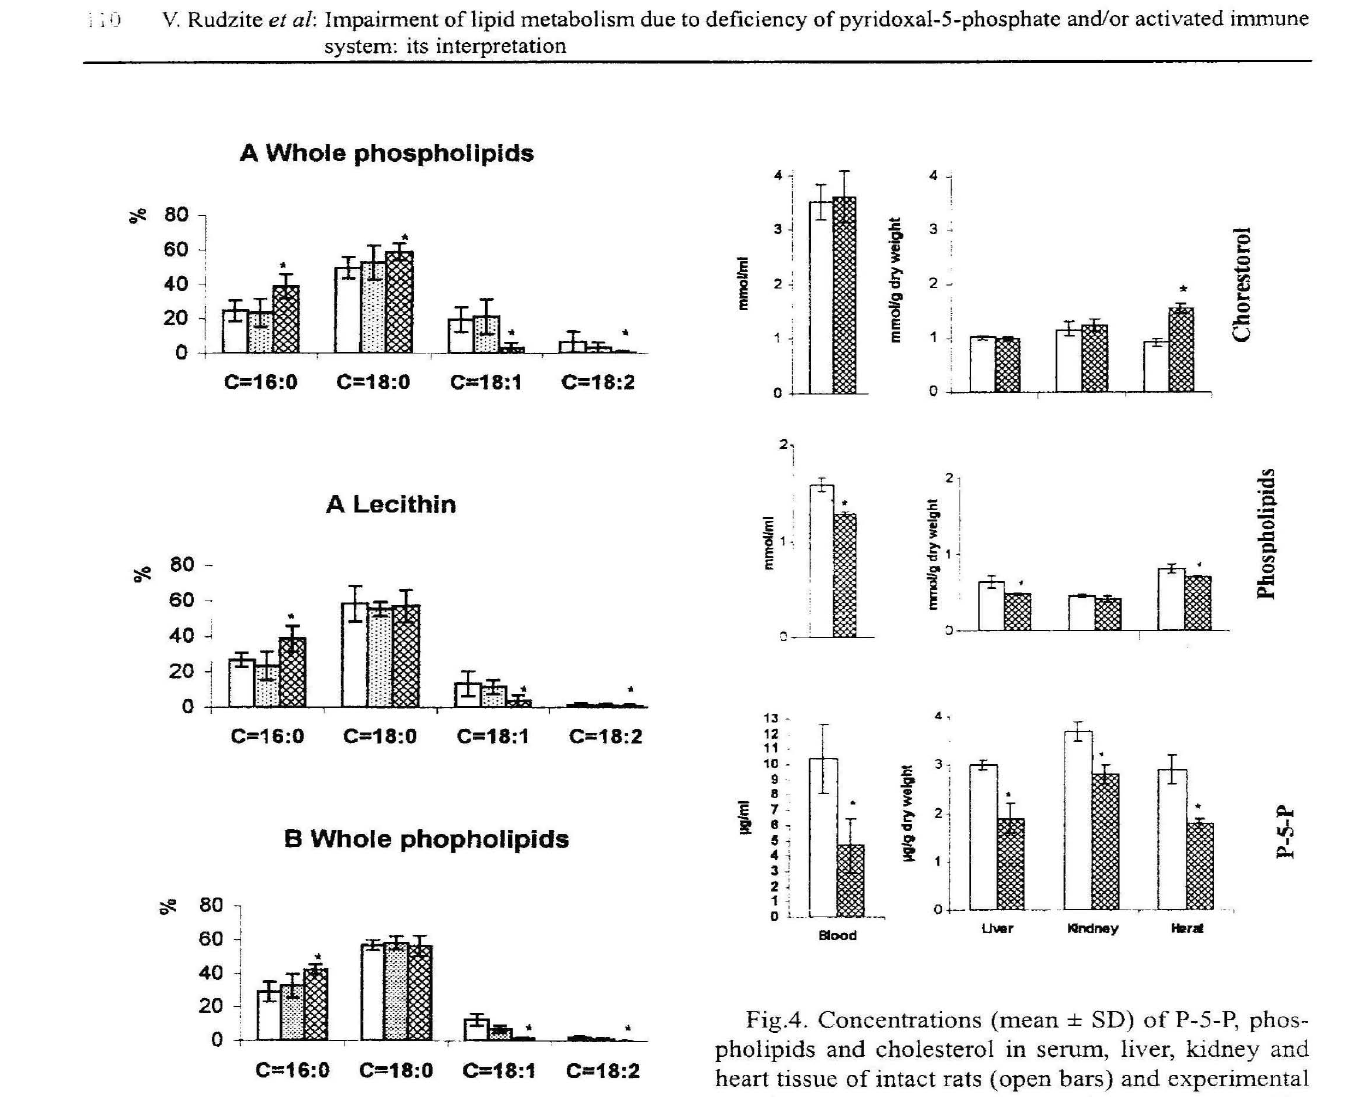
Fig.3. Content in percent (mean ± SD) of palmitic (C=16:0), stearic (C=18:0), oleic (C=18:1), and linole ic (C=18:2) acids in serum whole phospholipids and lecithin (A) as well as in whole phospholipids of ery throcyte membranes (B) in healthy individuals (open bars), in cardiovascular patients without P-5-P-defi ciency (dotted bars) and in cardiovascular patients with P-5-P-deficiency (hatched bars); the difference is sta tistically significant (P < 0.05).